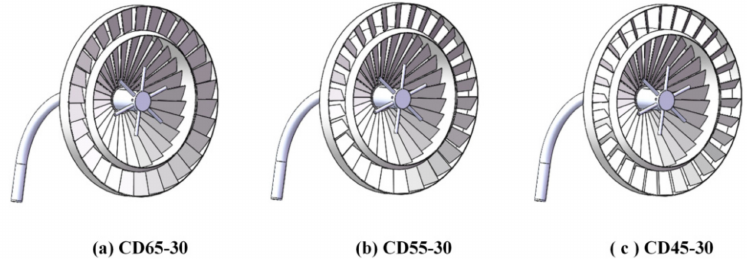
Figure 11. Three-dimensional diagram of different secondary-stage swirl blade angles.